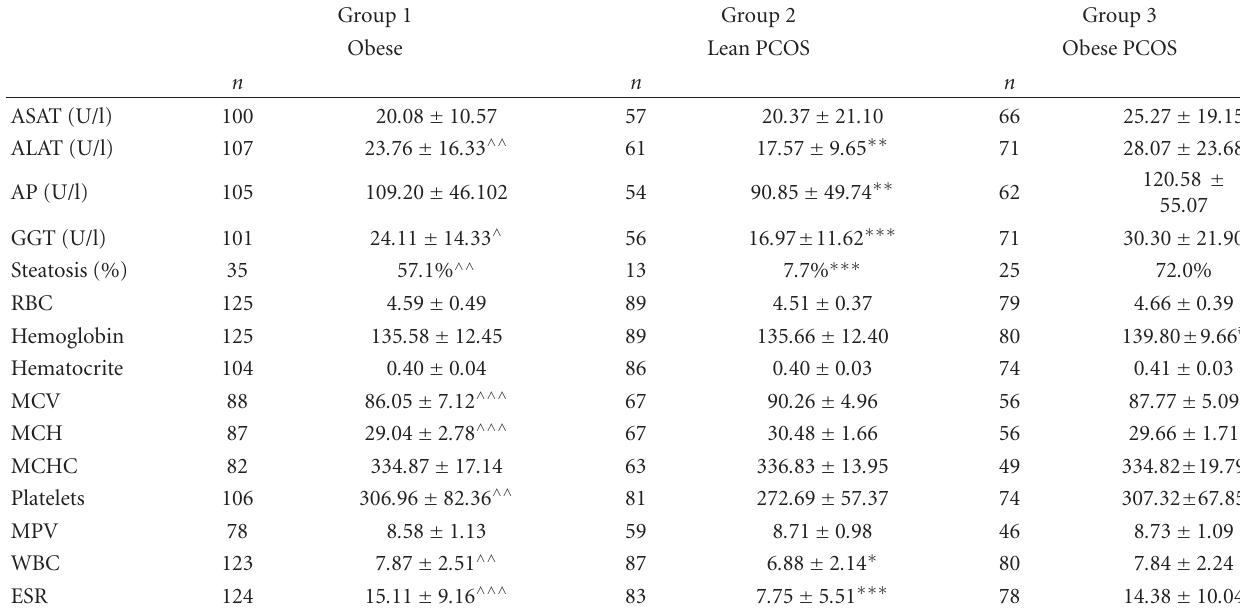
Table 3: Comparison between liver enzymes and the rate of liver steatosis and the blood count between the three groups. Group 1 Group 2 Group 3 Obese Lean PCOS Obese